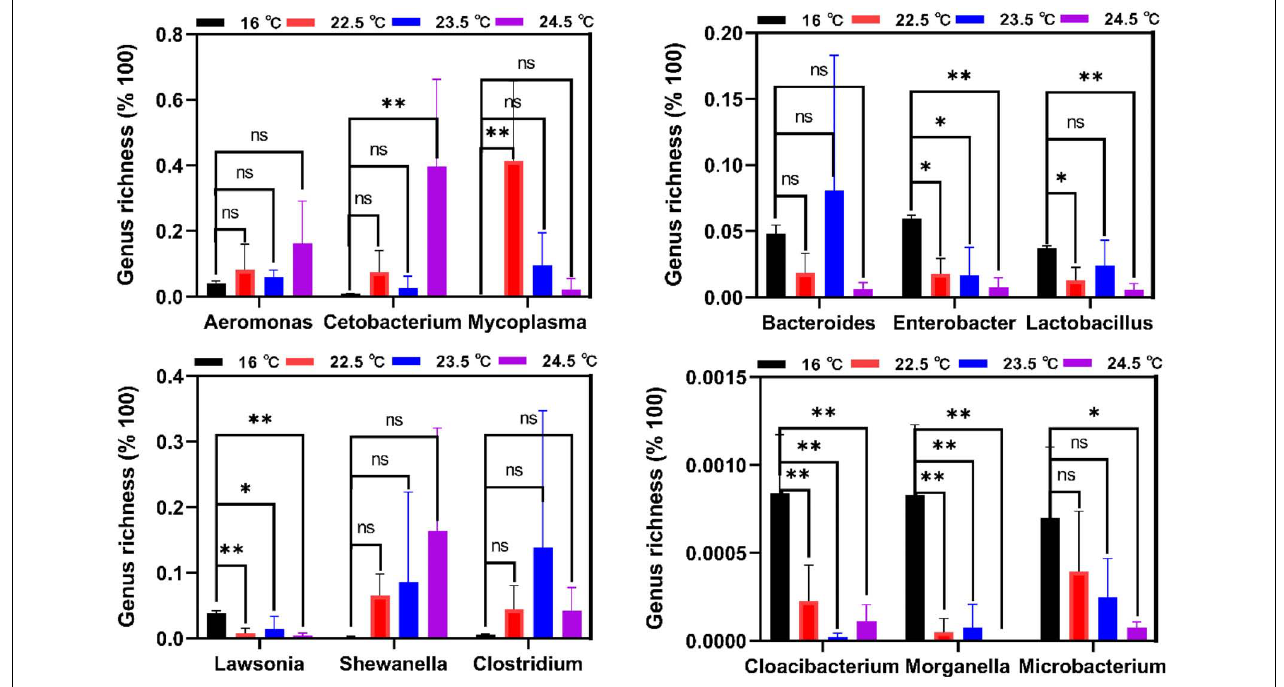
FIGURE 5 | Biomarkers of discriminative bacteria (genus) in different temperature groups identified. ∗ P < 0.05; ∗∗ P < 0.01; ns, no significance.